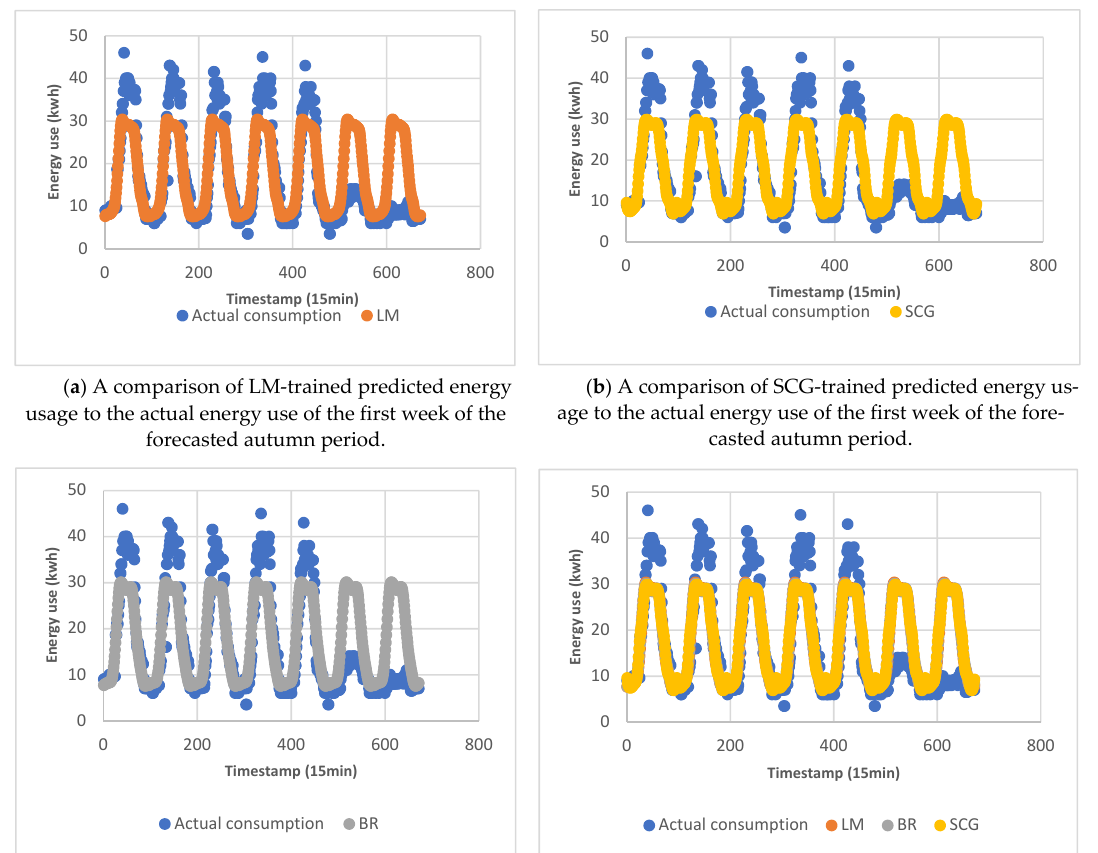
( c ) A comparison of BR-trained predicted energy usage to the actual energy use of the first week of the forecasted autumn period. ( d ) A comparison of LM-, BR-, and SCG-trained pre- dicted energy usage to the actual energy use of the first week of the forecasted autumn period. Figure 3. A comparison of ANN training algorithm predictions.